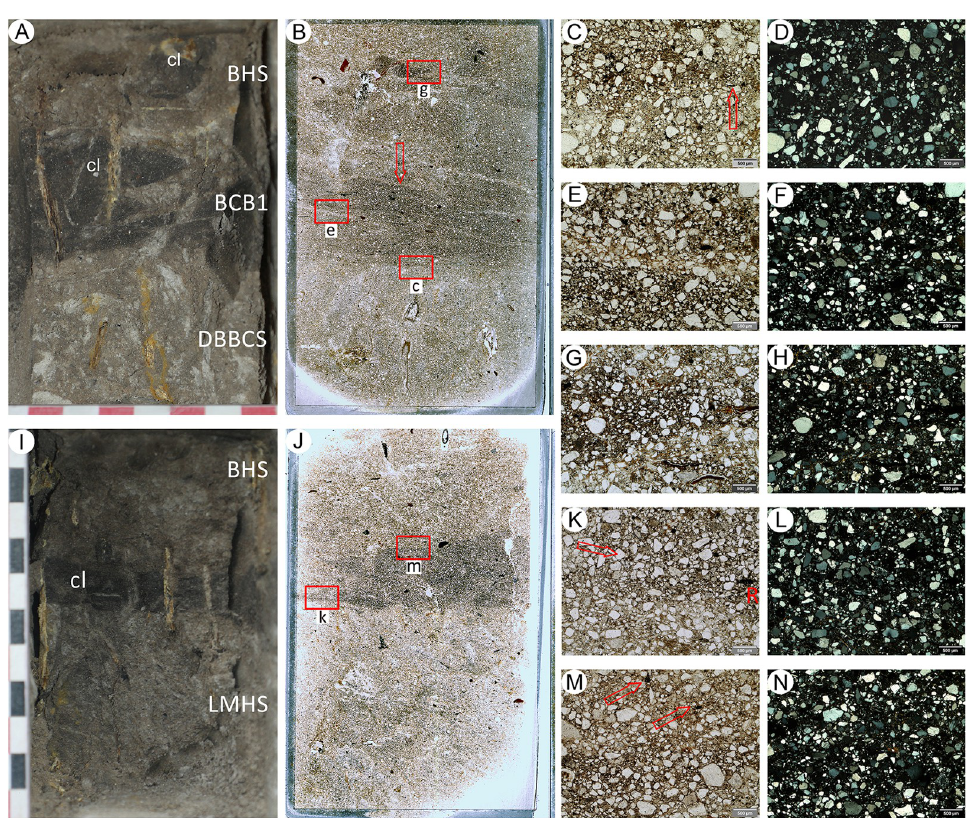
Fig 12. Contacts between lithologic units at the boundary between the archaeological layers of the upper part and sterile layers of the lower part of Deacon’s [11] Rietheuvel Member. A: Sequence of Light Mottled Herbaceous Sand (DBBCS) overlain by Black Clay Band (BCB1) and Brown Herbaceous Sands (BHS), with erosive contact between BCB1 and BHS. Clods (cl) of BCB1 are embedded within BHS, sometimes lying on BCB1 top (detachment niche of sample AMZ17/4/3-4-5). B) High-resolution scan of thin section from the same sample, showing relatively sharp, probably non erosive boundary between LMHS and BCB (c), dark AOM-rich and light AOM-poor fine laminae (e), clod of BCB in BHS (g); note that the thin section scan is turned rightside left because of thin section preparation. C) microphotograph as in (c): dark BCB1 layer overlying moderately sharp boundary with DBBCS (PPL). D) as in B), XPL; quartz grains in DBBCS are slightly more rounded than in BCB1. E) as in (e): finely laminated BCB1 with coarse AOM aggregates and AOM-poor lamina at the centre (PPL). F) as in E), PPL. G) as in (g): dark, AOM-rich clod embedded in BHS, showing strict resemblance with BCB1 (PPL). H) as in G), XPL. I) Sequence of LMHS overlain by BHS, with erosive contact between LMHS and BHS, much sharper than in B and C. Clods (cl) of BCB1 are reworked into BHS, lying on LMHS top (sample AMZ17/1/3-5). J) High-resolution scan of thin section from sample AMZ17/4/3-5, showing very sharp erosive boundary between LMHS and a clod of BCB embedded in BHS (k). The top boundary (m) of the clod is diffuse, probably because of BCB1 fine material diffusely embedded in BHS; note that the thin section scan is turned rightside left because of thin section preparation. K) as in (k), sharp boundary between LMHS and BCB1 clod (red arrow); a 0.5 to 1mm-thick layer (R) of reworked BCB1 material, or in situ residue of BCB1, lies on LMHS (PPL). L) as in K, XPL. M) diffuse limit between BCB1 clod and embedding BHS, probably with finely dispersed BCB1 sediment reworked into BHS (arrows) (PPL). N) as in M,